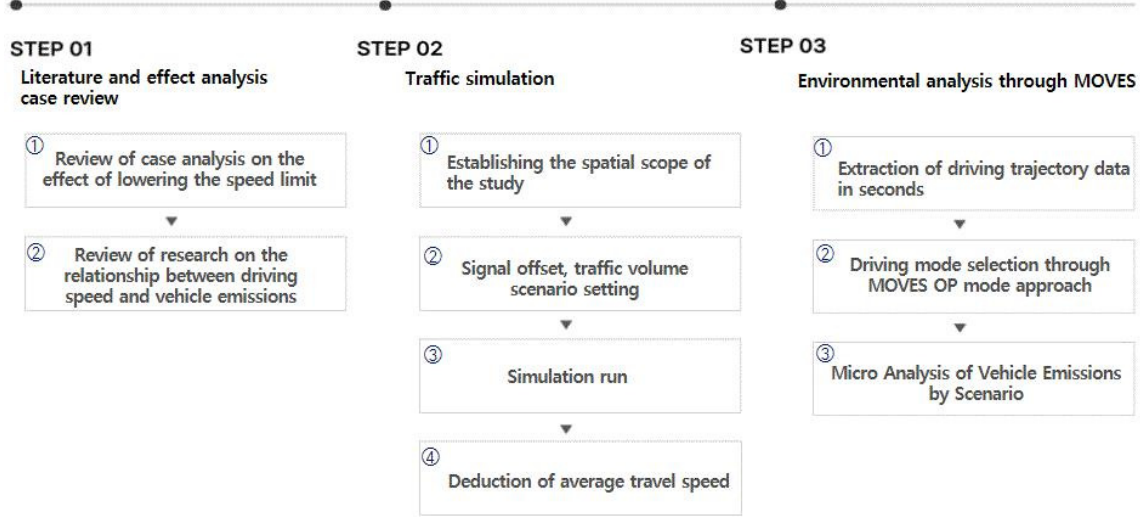
Figure 1. Study procedure.